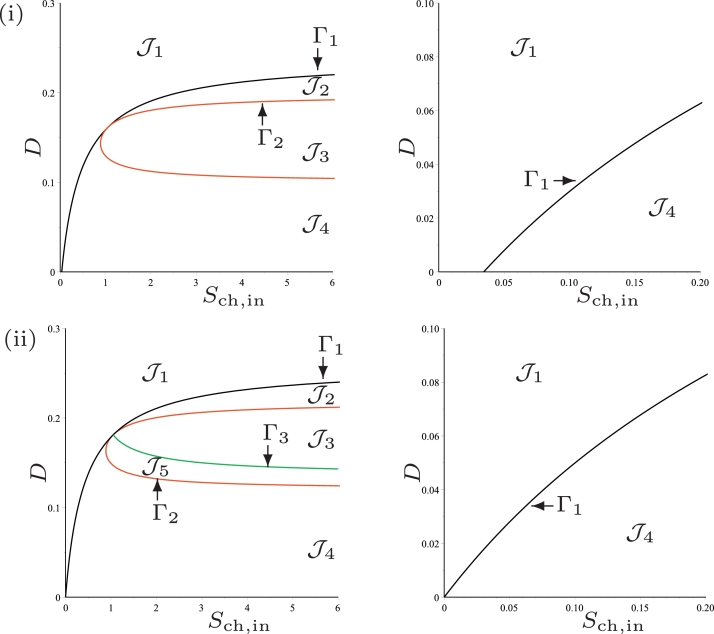
The curves Γ1 (black), Γ2 (red) and Γ3 (green) for case (d). (i) : regions of steady-state existence, with maintenance. (ii) : regions of steady-state existence and their stability, without maintenance. On the right, a magnification for 0 < D < 0.1. (For interpretation of the references to colour in this figure legend, the reader is referred to the web version of this article.)